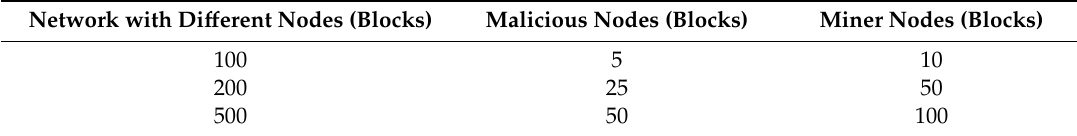
Table 3. Network configuration with miners and number of nodes (blocks) with malicious nodes (blocks) and miners.